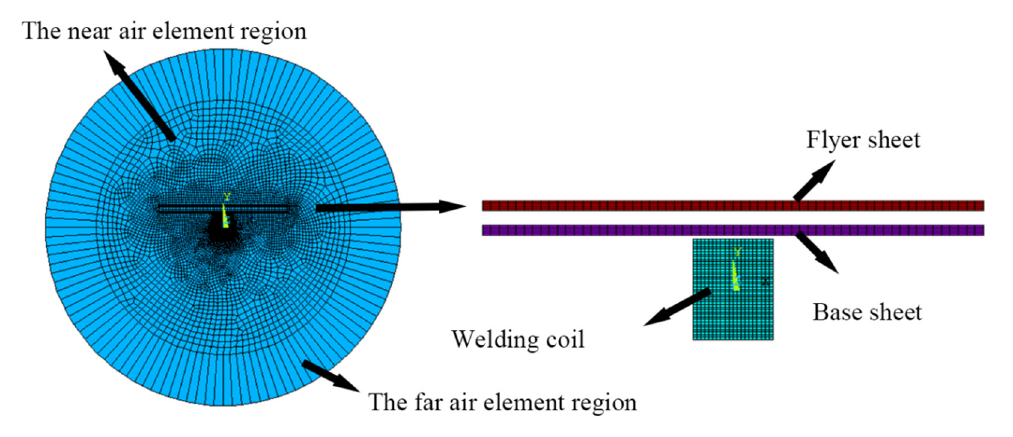
Figure 9. Two-dimensional electromagnetic field model and grid.